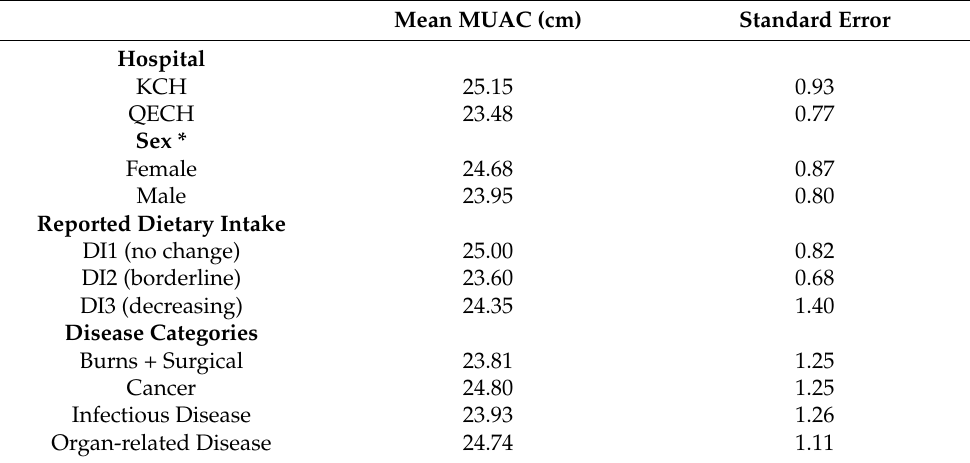
Table 3. Least-squares predicted mean MUAC.